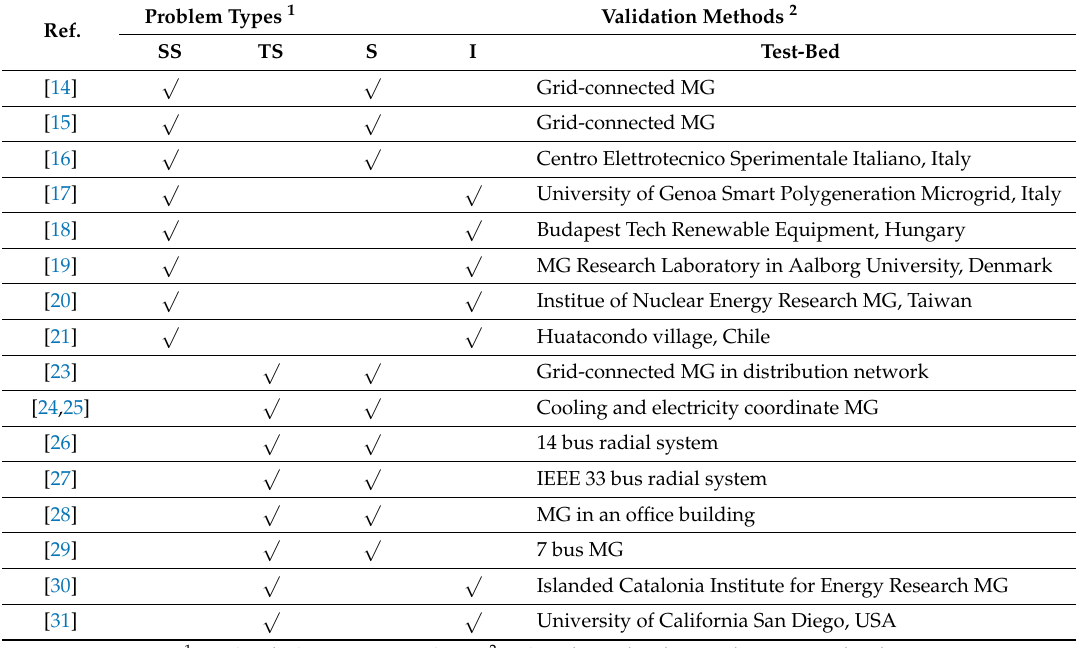
Table 1. Summary of previous studies on the optimal scheduling using ESS in MG.